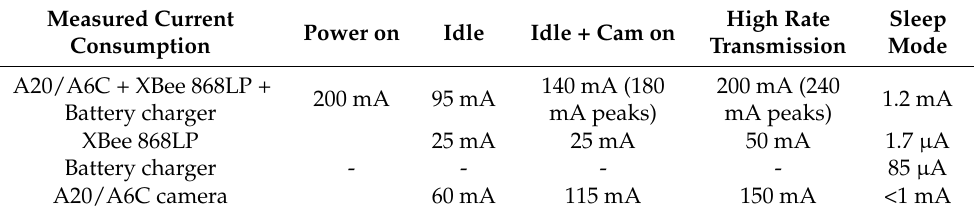
Table 1. Measured currents of the remote node in different states.